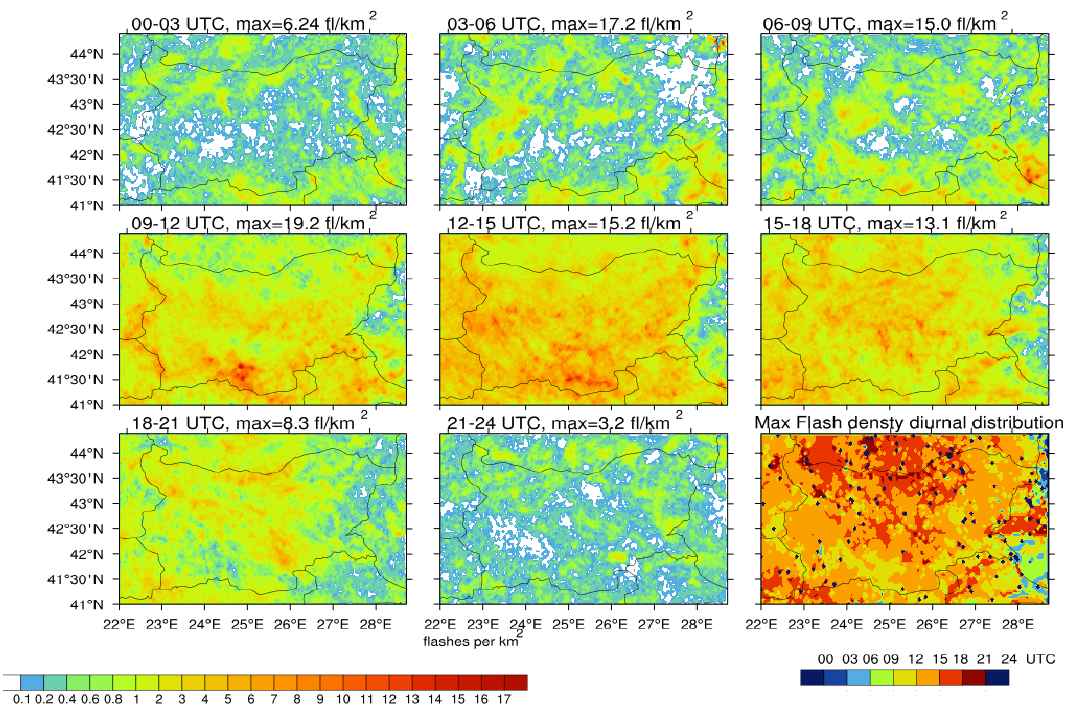
Figure 15. Spatial distribution of flash density in the time intervals between 00 and 03 UTC, 03 and 06 UTC, 06 and 09 UTC, 09 and 12 UTC, 12 and 15 UTC, 15 and 18 UTC, 18 and 21 UTC, and 21 and 24 UTC, and diurnal distribution of the maximum flash density over the studied domain (spatial resolution: 0.05 × 0.05 deg).